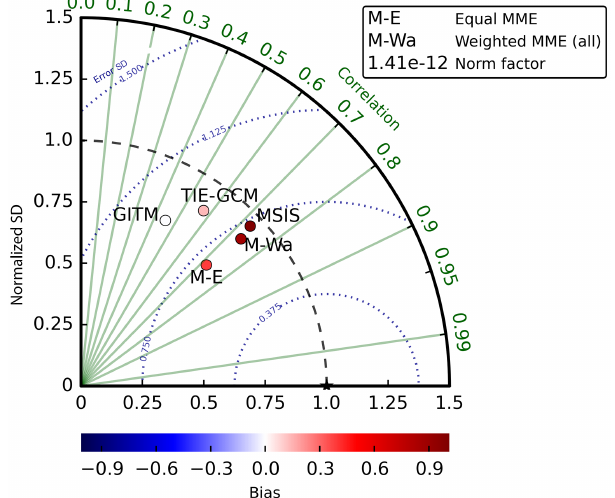
Figure 11. Modified Taylor diagram for the two MMEs: equal and all-time weighted as well as GITM, TIE-GCM, and NRLMSISE- 00 (MSIS) compared to the CHAMP observations for the third test scenario. Details of how to read the diagram are described in Fig. 2.